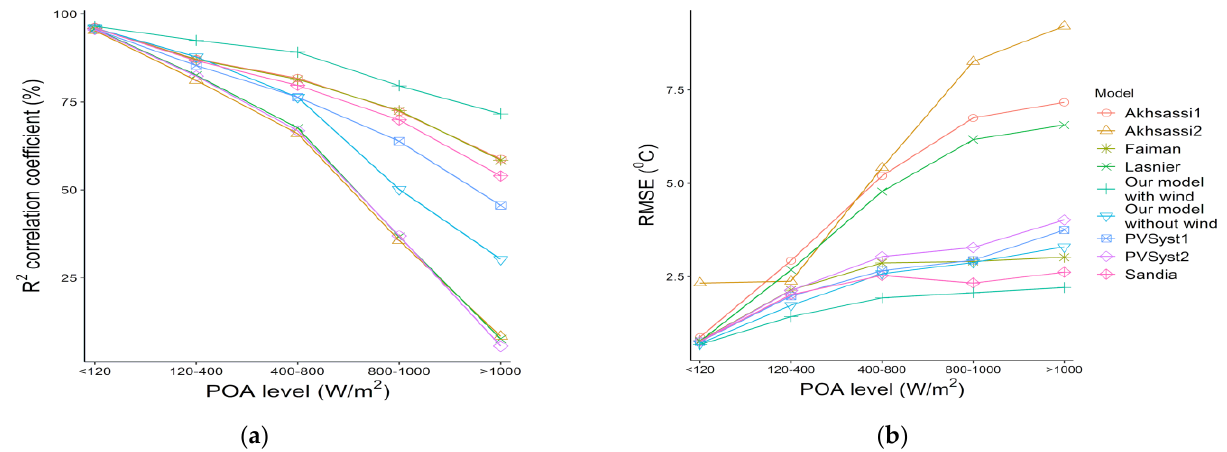
Figure 3. Correlation between measured and calculated module temperature for different POA levels obtained with the studied models for Tri An, Vietnam (time recording = 5 min): ( a ) correlation factor 𝑅 2 ; ( b ) 𝑅𝑀𝑆𝐸 .